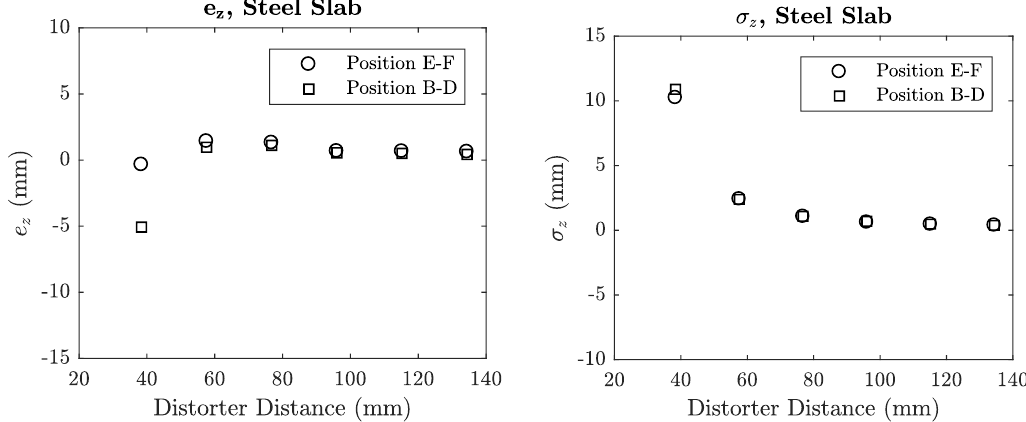
Figure A15. Position error plots for steel slab, locations B and D and E to